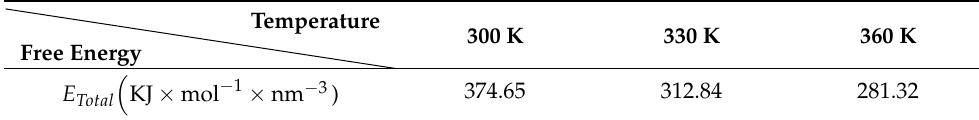
Table 5. The interaction energy of nanoparticles with water per unit volume.